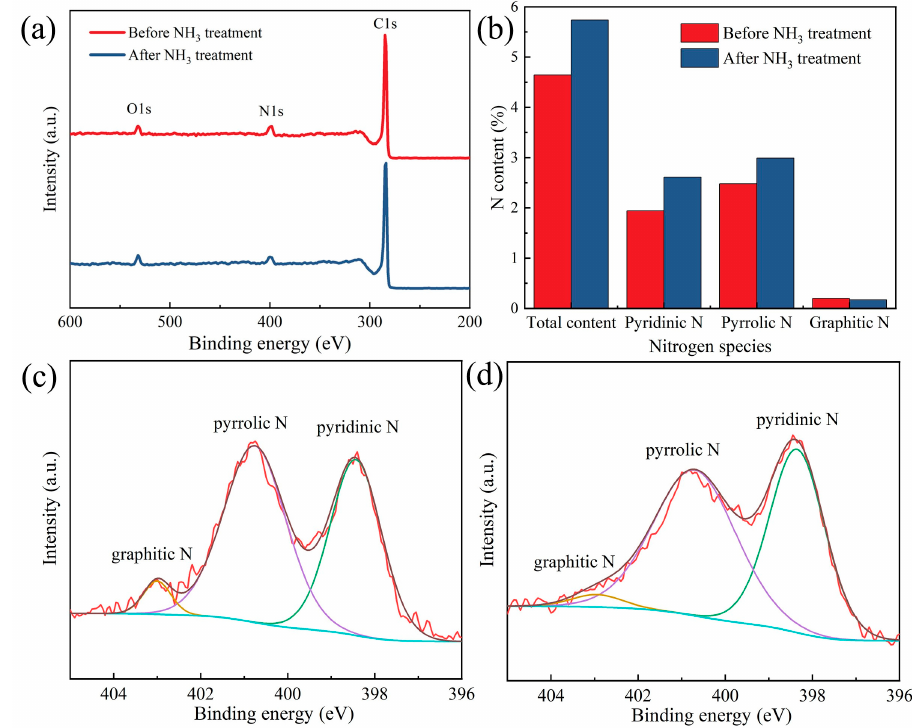
Figure 8. ( a ) XPS spectra, ( b ) ratios of N content, N1s spectra for ( c ) CNMs-CC before NH 3 treatment and ( d ) CNMs-CC after NH 3 treatment. and ( d ) CNMs-CC after NH 3 treatment.